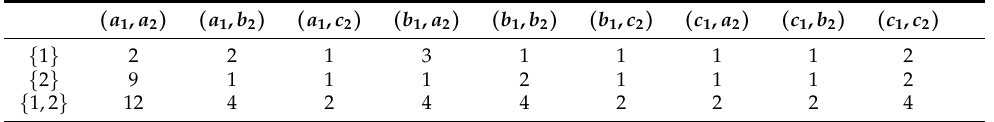
Table 2. Coalitions’ utilities of the 2-person biform game